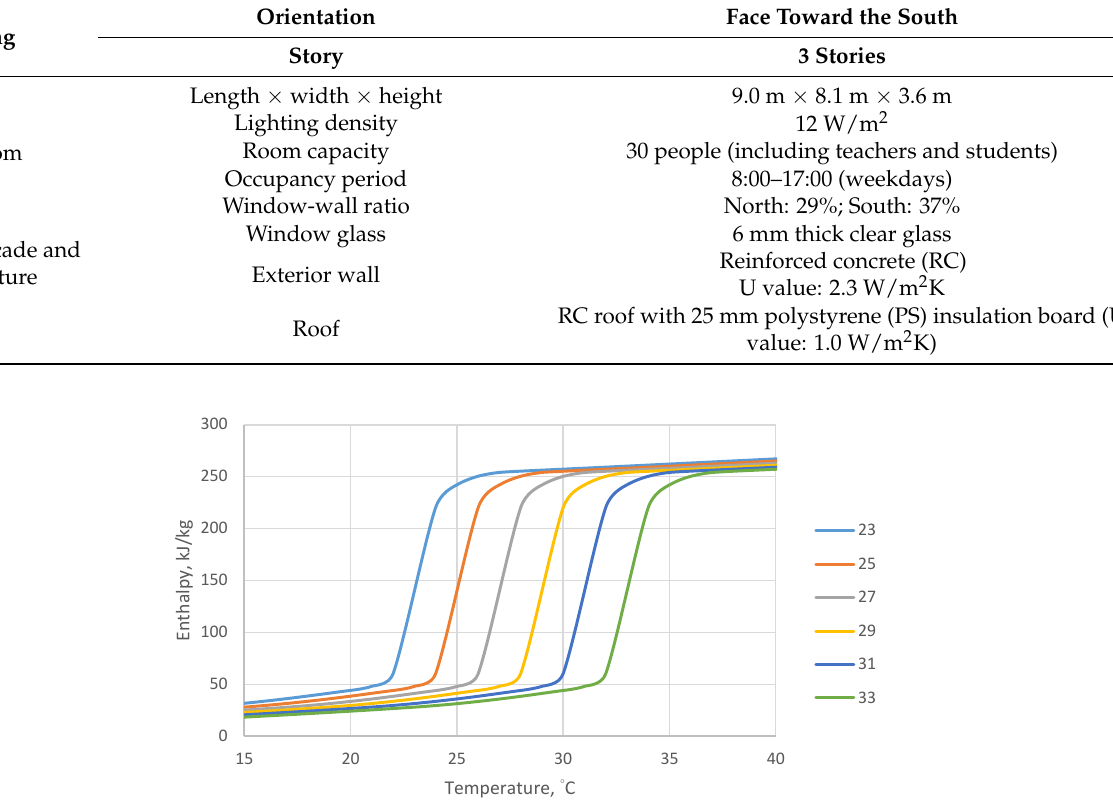
Figure 2. Enthalpy–temperature curves for BioPCM.